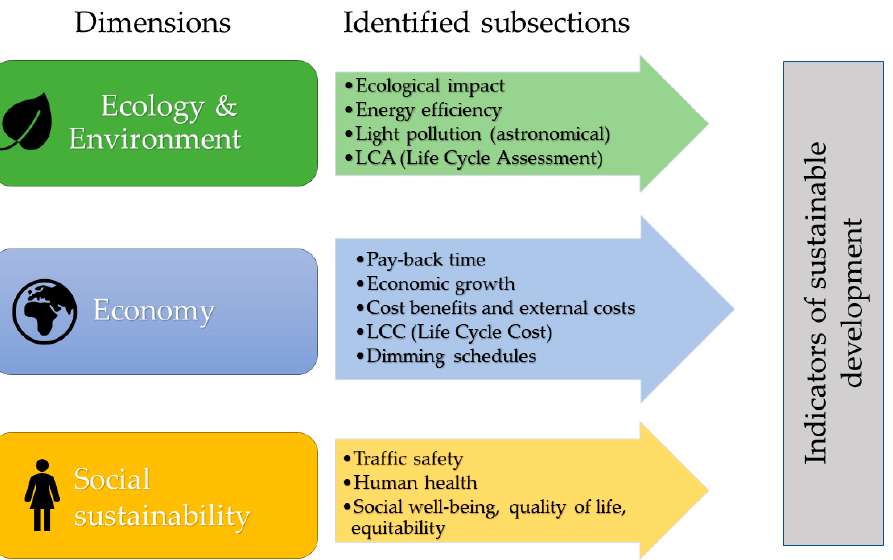
Figure 1. Overview of the dimensions and hitherto identified subsections in the framework of indicators of sustainable development for exterior lighting [18] .